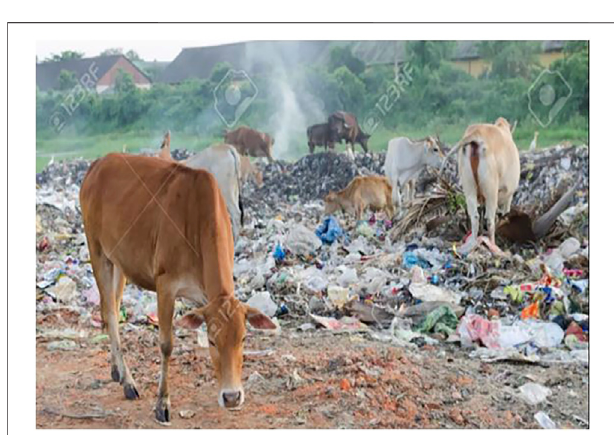
FIGURE 3 | Animals in a Polluted environment grazing on polluted soil(https://www.123rf.com/photo_29,849,393_cattle-and-land-pollution. html).